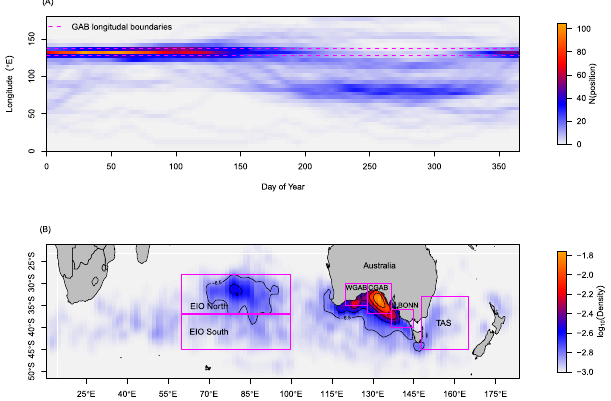
Figure 5. ( A ) Frequency of longitudes (colour) by day-of-year (DOY). ( B ) Kernel density estimates of locations classified as resident, identifying six main residency regions north-eastern Indian Ocean (EIO North), south-